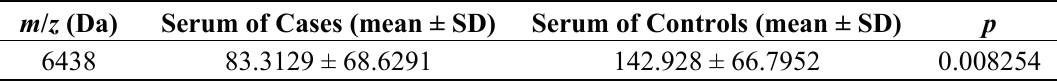
Table 1. m / z of a 6438 Da protein in the Wilms’ tumor and the normal control groups.